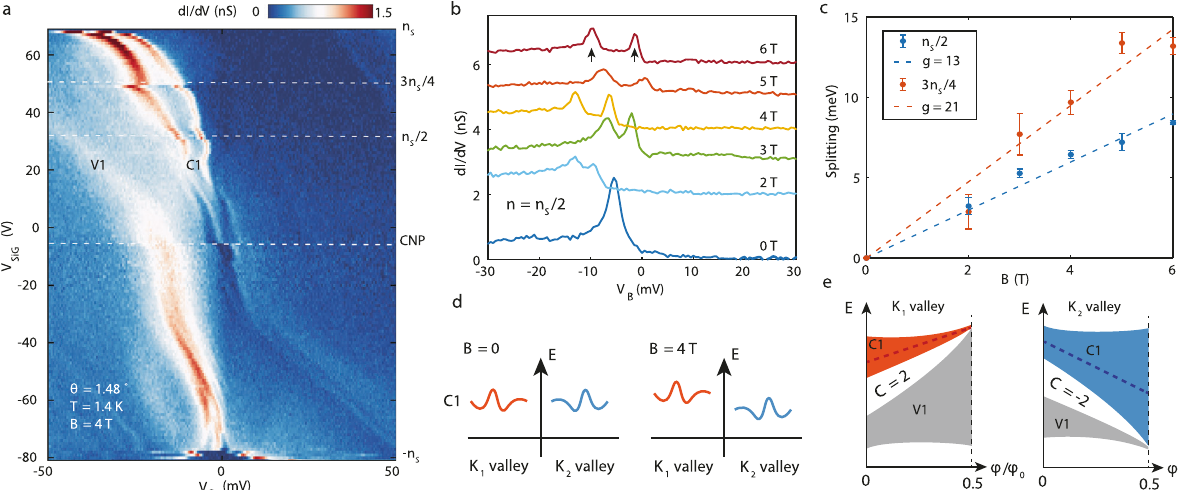
Fig. 5 Splitting of vHs under perpendicular magnetic fi elds. a STS measurements between − n S and n S under a perpendicular magnetic fi eld of 4 T, taken with V set = − 400 mV, I set = 800 pA and V mod = 0.5 mV. b Tunneling spectra at half fi lling of the C1 band under various perpendicular magnetic fi elds. Traces are offset for clarity. c Splitting of the C1 vHs as a function of perpendicular magnetic fi eld B at half fi lling (blue symbols) and three-quarter fi lling (red symbols), obtained from Gaussian fi tting of the split peaks. The error bars represent 95% con fi dence bounds of the fi t. The dashed lines are the linear fi t of the splitting, corresponding to 4 E ¼ 2 g μ B with g-factor noted in the legend. d schematic of C1 band ’ s response to magnetic fi elds. The two valleys B (red and blue) shift in opposite energy directions due to their opposite valley Chern numbers. e illustration of valley splitting estimation based on Chern number of the band. On K 1 ( K 2 ) valley, the CNP gap between V1 and C1 carries Chern number C = 2 ( C = − 2), which move to the top of C1 band (bottom of V1 band) at half fl ux per moiré unit cell. The red and blue dashed lines represent the vHs of C1 band in the two valleys, and w c and w v. denote the bandwidth of C1 and V1 band at zero fi